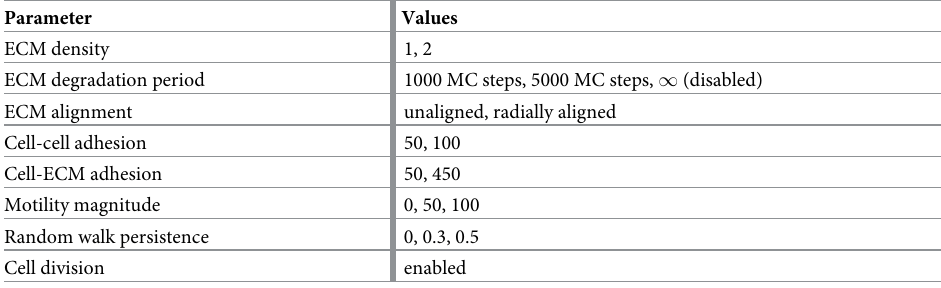
enabled Listed are the number of values per parameter, as well as the total number of parameter combinations resulting from this (see section 4.2 for more detail). For each simulation, five replicates were